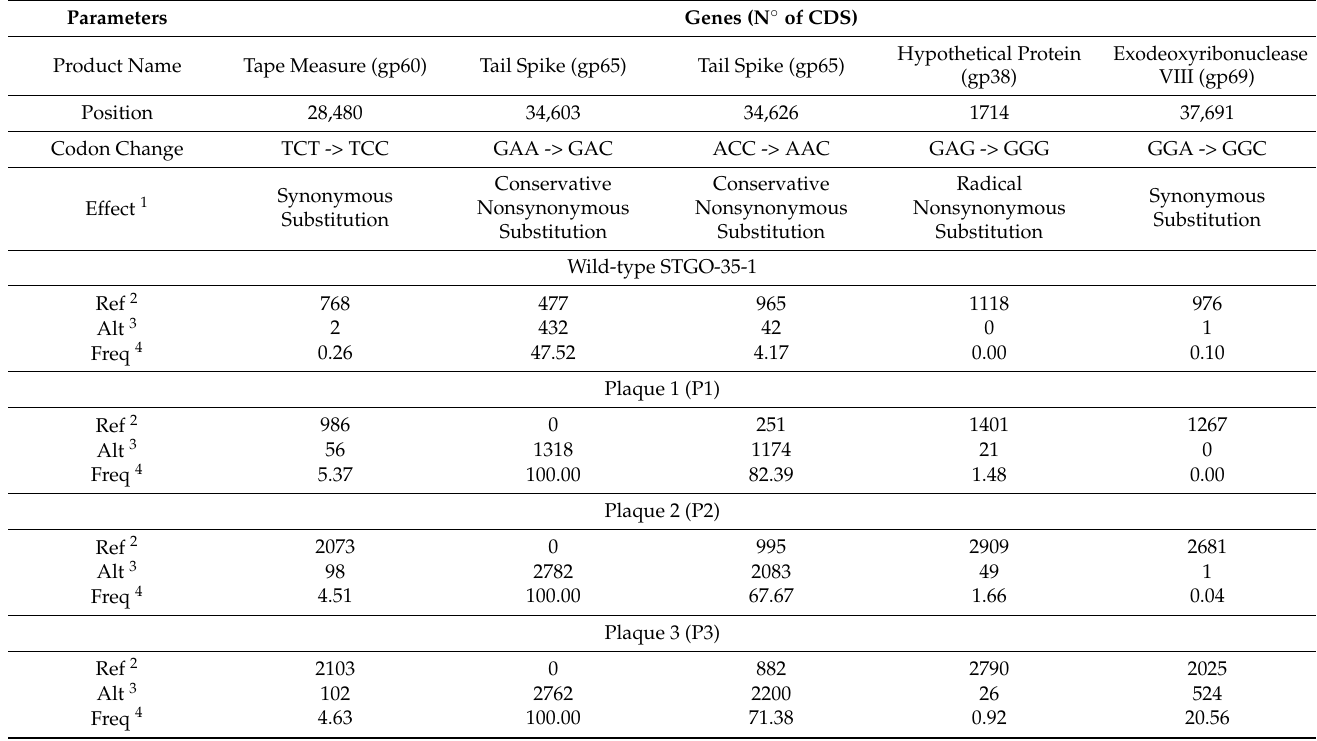
Table 3. Information of different sub-isolates and phage selections obtained under laboratory